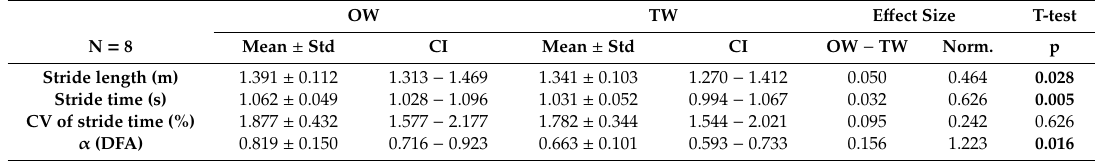
Table 4. Comparison of spatiotemporal parameters between TW and OW condition.